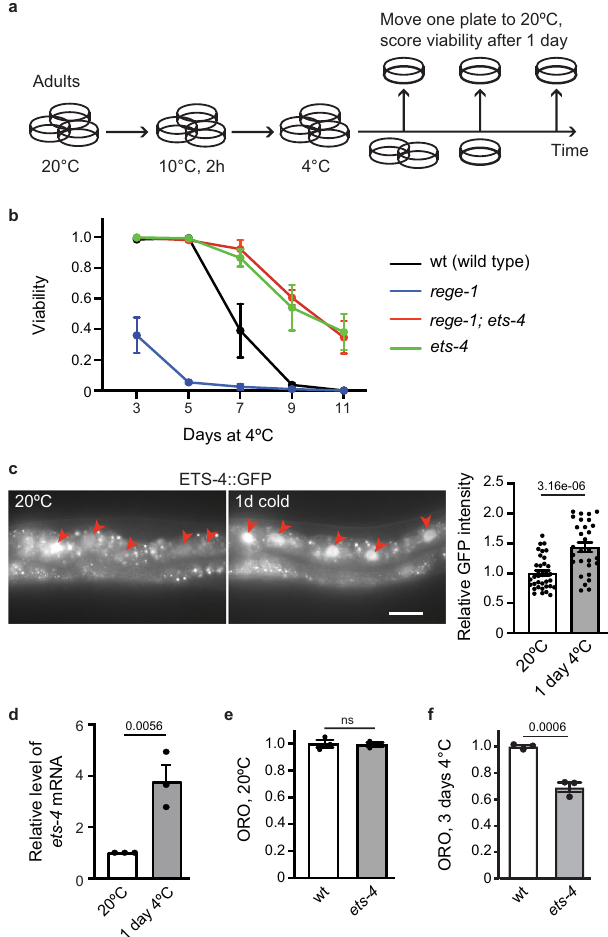
Fig.1|ETS-4isanegativeregulatorofcoldsurvival.a Representationofatypical cold-survivalexperiment.One-day-oldadultnematodes,grownat20°Cinmultiple plates, were cold-adapted for 2h at 10°C and then shifted to 4°C. Every few days, one plate was transferred back to 20°C, and after 1 day of recovery, the animals were scored for viability. b Inactivation of ets-4 increases cold survival. Animals of the indicated genotypes were cold-exposed asin 1a.Note that ets-4(rrr16) mutants, like rege-1(rrr13); ets-4(rrr16) double mutants, survived cold better than wild type (mutantallelesindicatedinparentheses).Errorbarsrepresentthestandarderrorof themean(SEM), n =3independentexperiments.200 – 350animalswerescoredper time point. c ETS-4 protein in upregulated in the cold. One-day-old adult ets- 4::GFP(rrr45) nematodes were cold-exposed as in 1 a . Representative images on the left show enhanced GFP fl uorescence in the intestinal nuclei (arrowheads). Scale bar: 20 μ m. The corresponding quanti fi cation is on the right. Error bars represent SEM, n =1 independent experiment, 30 – 40 nuclei examined per condition. d Cold upregulatesthe ets-4 mRNA.Wild-typenematodesweretreatedasin1 a .Thelevelof ets-4 mRNA,normalizedto act-1 mRNA,wasmeasuredbyRT-qPCRandisexpressed relative to control animals grown at 20°C. Error bars represent SEM, n =3 inde- pendent experiments. e , f Cold induces a faster loss of body fat in ets-4 mutants thanwild type.Wild typeor ets-4(rrr16) nematodesweregrownat 20°C( e )orwere incubatedinthecoldfor3days( f ),asin1 a .Bodyfatwasquanti fi edbystainingwith the lipophilic dye oil red O (ORO). Error bars represent SEM, n =3 independent experiments. 10 – 15 animals ( e ) or 30 animals ( f ) were scored per replicate and strain. c – f . p values calculated using unpaired one-sided t -test; ns not signi fi cant. Source data are provided as a Source Data fi